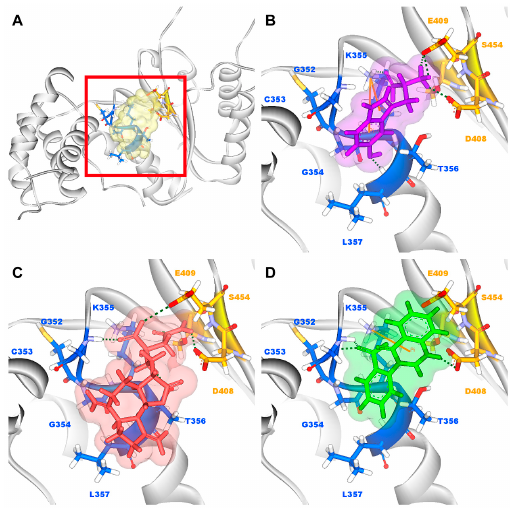
Figure 3. ( A ) Binding site of paraplegin and docking pose of paraplegin complexes with ( B ) 5-hydroxy- L -tryptophan; ( C ) saussureamine C; and ( D ) 3-(2-carboxyphenyl)-4(3 H )-quinazolinone.